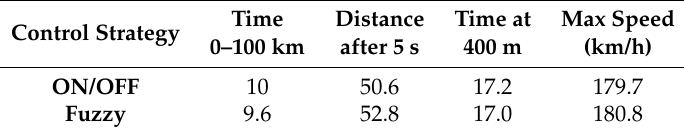
Table 8. Performance characteristics results [18].